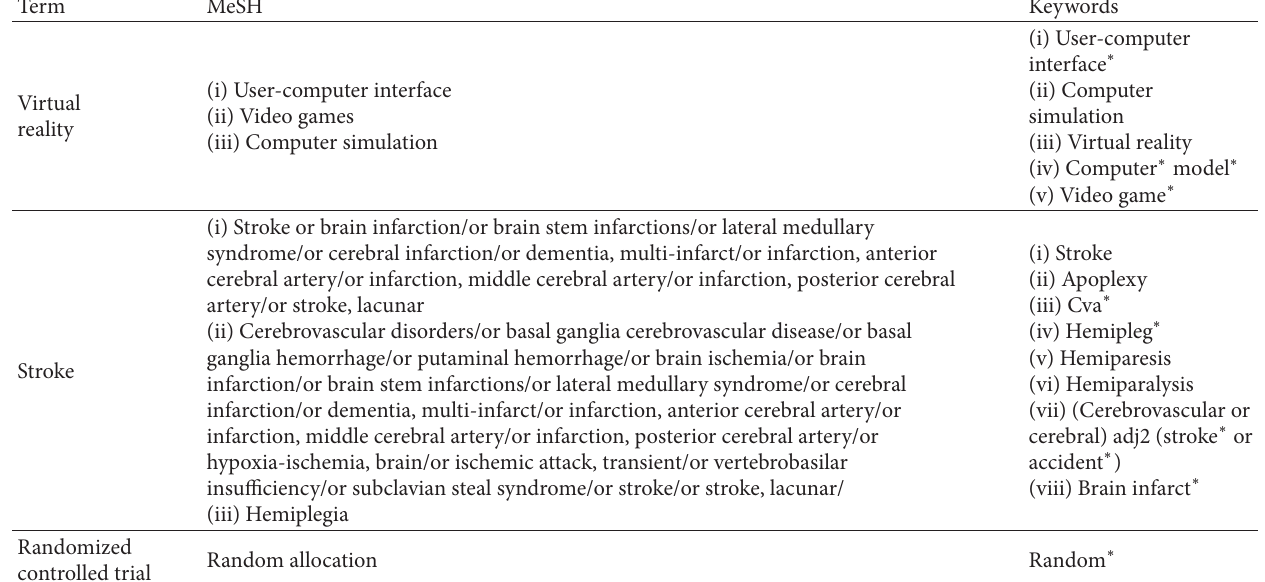
Table 5: Example of Medline search via